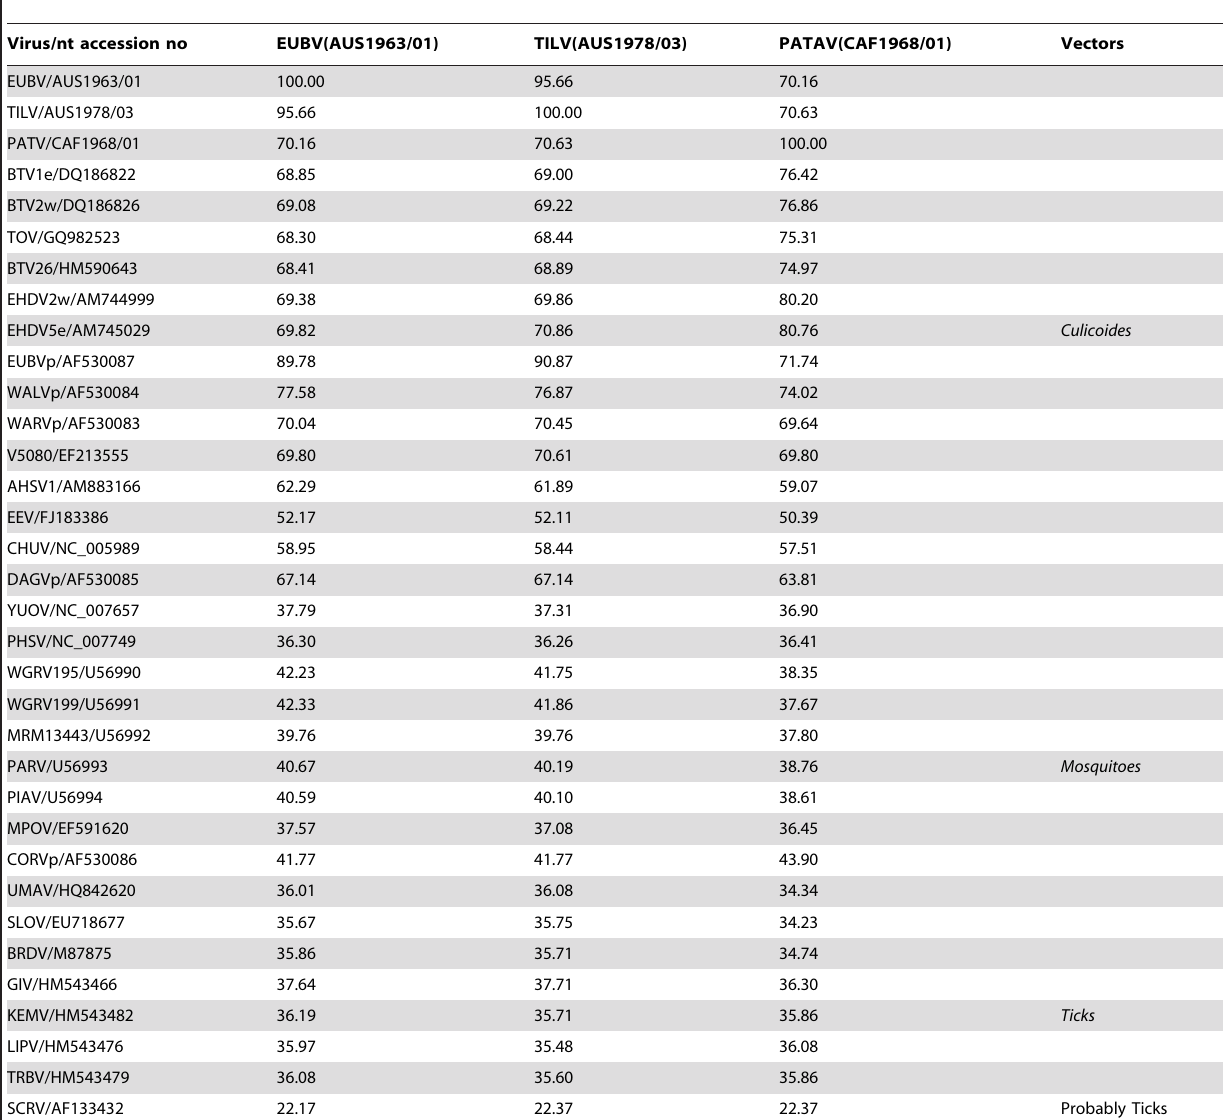
Table 4. Inner core protein (T2) amino acid (aa) identities (%) between EUBV, TILV and PATAV with other orbiviruses.